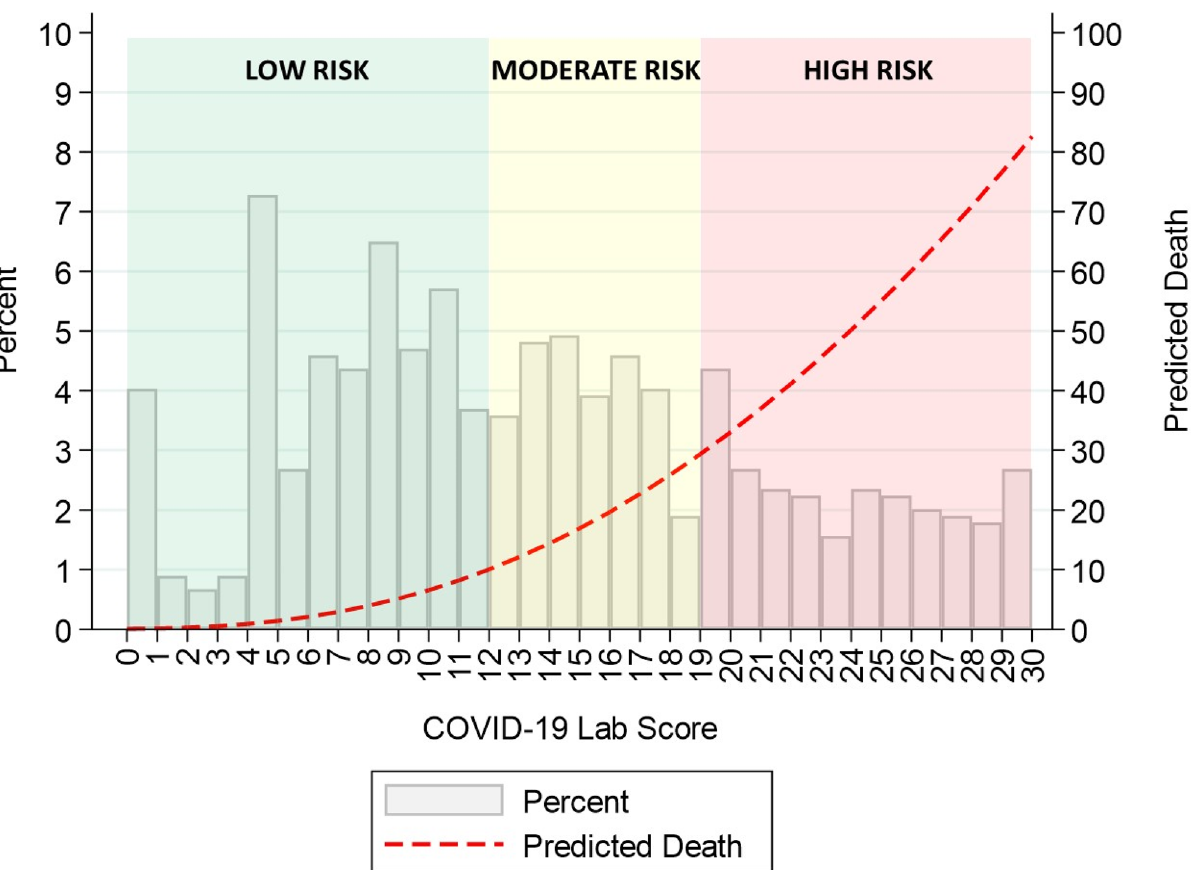
Figure 2. COVID-19 lab score: histogram and predicted mortality. Represents the risk of mortality depending on the score, divided in three different